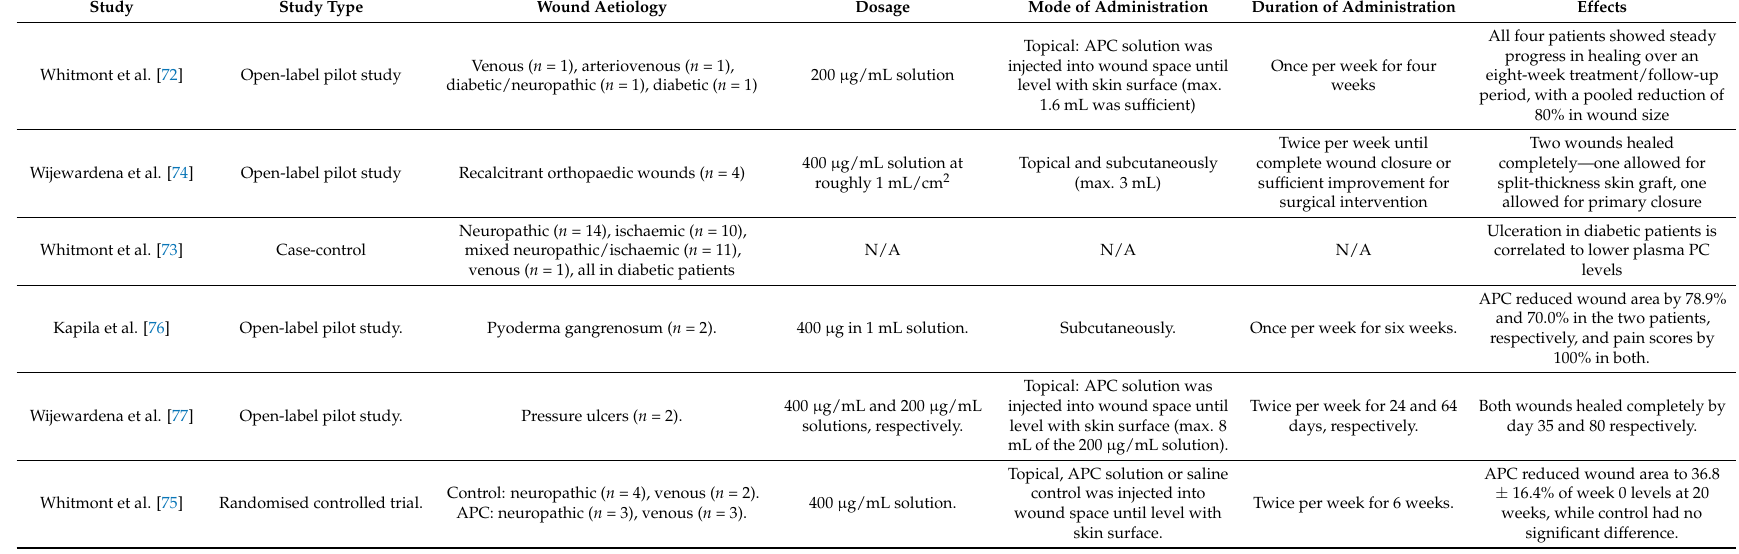
Table 2. APC in Clinical